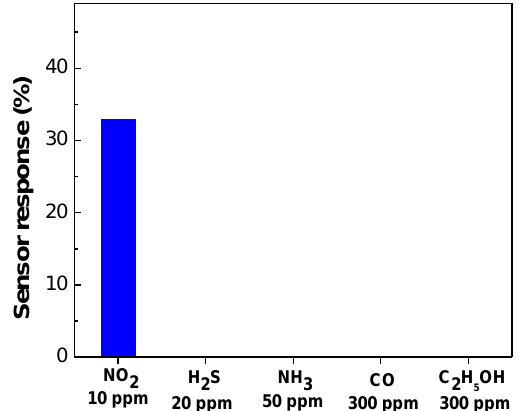
Figure 13. Selectivity histogram for sample S6 at an operating temperature of 150 °C.